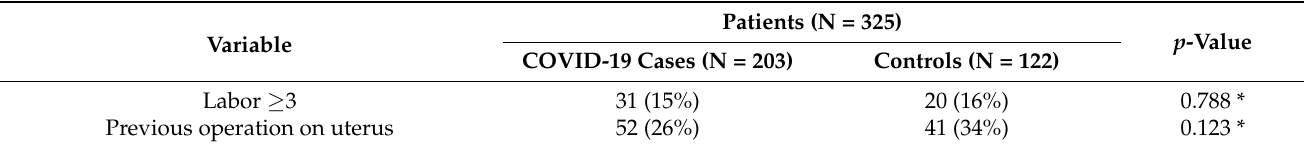
Table 1. Patient characteristics after matching